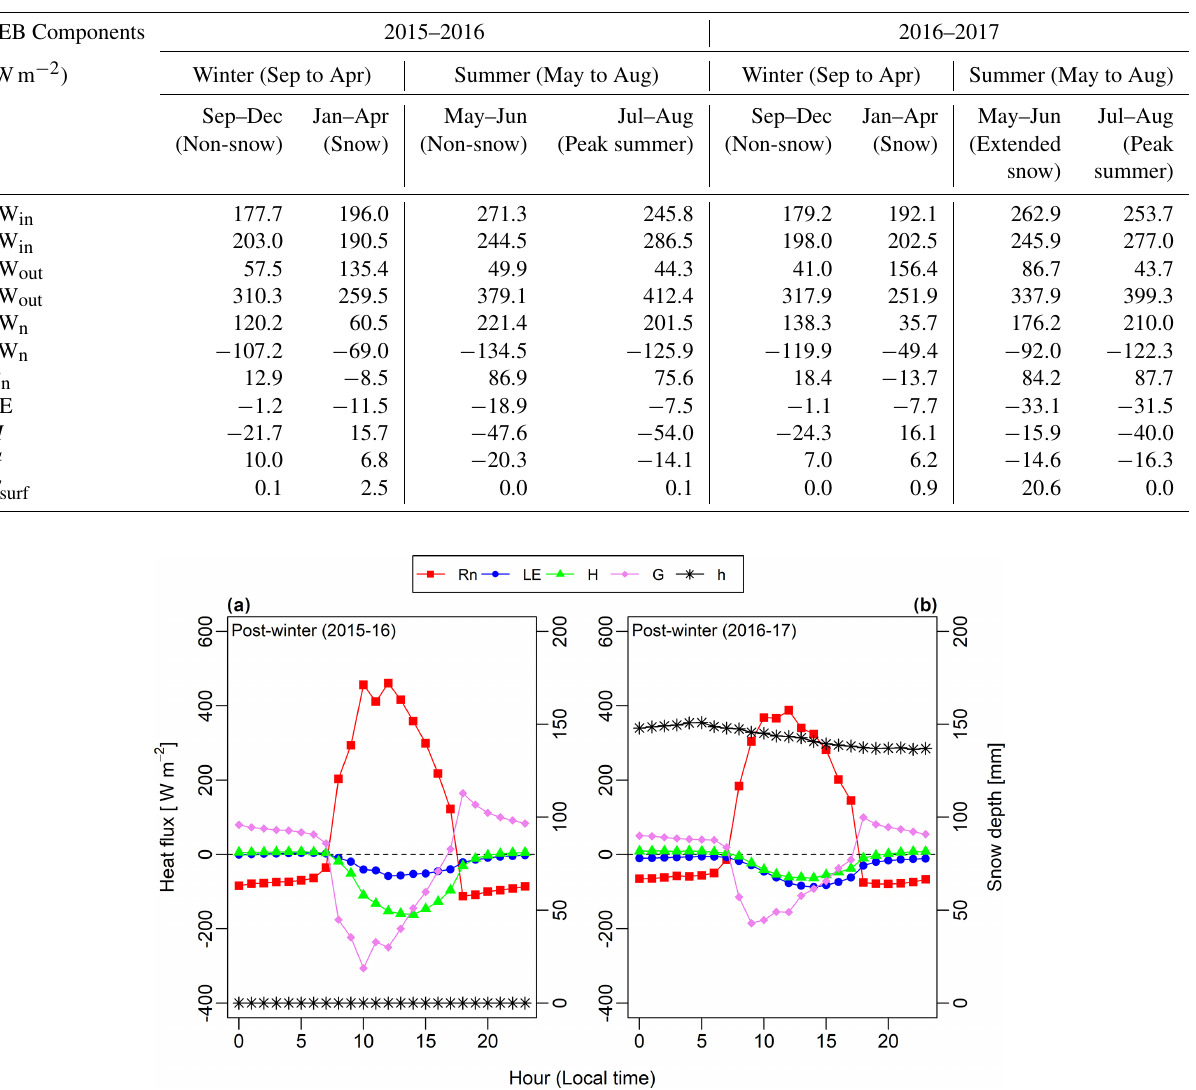
Figure 8. The diurnal change in GEOtop-modelled seasonal surface energy fluxes for (a) early summer 2015–2016 and (b) early